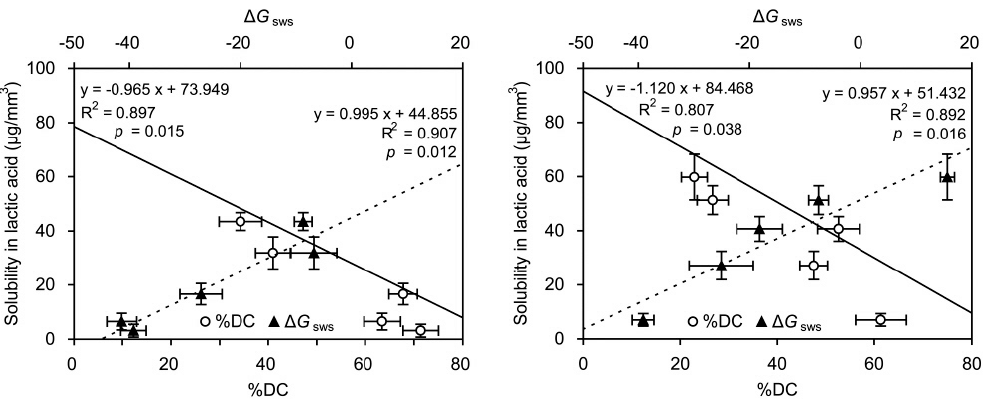
Figure 7. Graphs of linear regression of solubility ( μ g/mm 3 ) as a function of degree of conversion (%DC) and degree of hydrophilicity ( Δ G sws ). The horizontal and vertical bars indicate standard deviations.